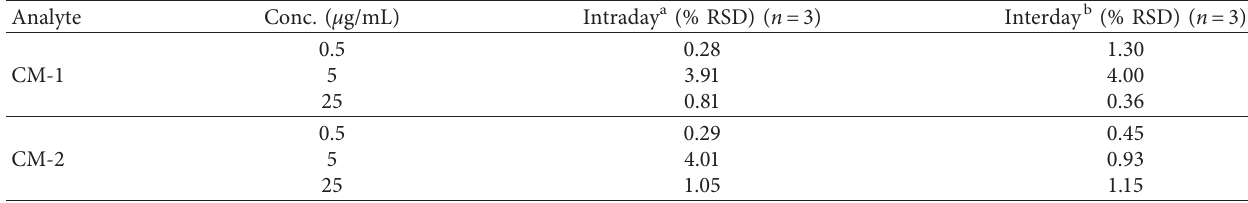
Table 2: Analytical results of repeatability and intermediate precision for two compounds in the C. myrrha sample. Analyte